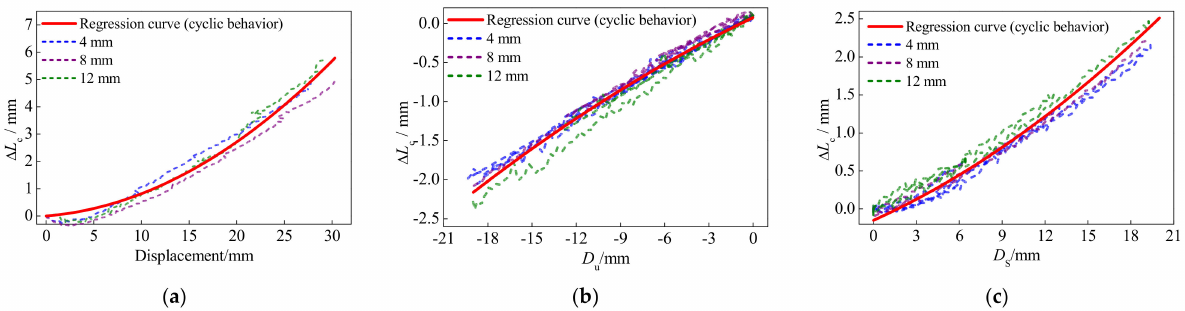
Figure 16. Anchor colloidal deformations of the BFRP tendons: ( a ) first loading cycle; ( b ) unloading cycle; ( c ) second loading cycle.